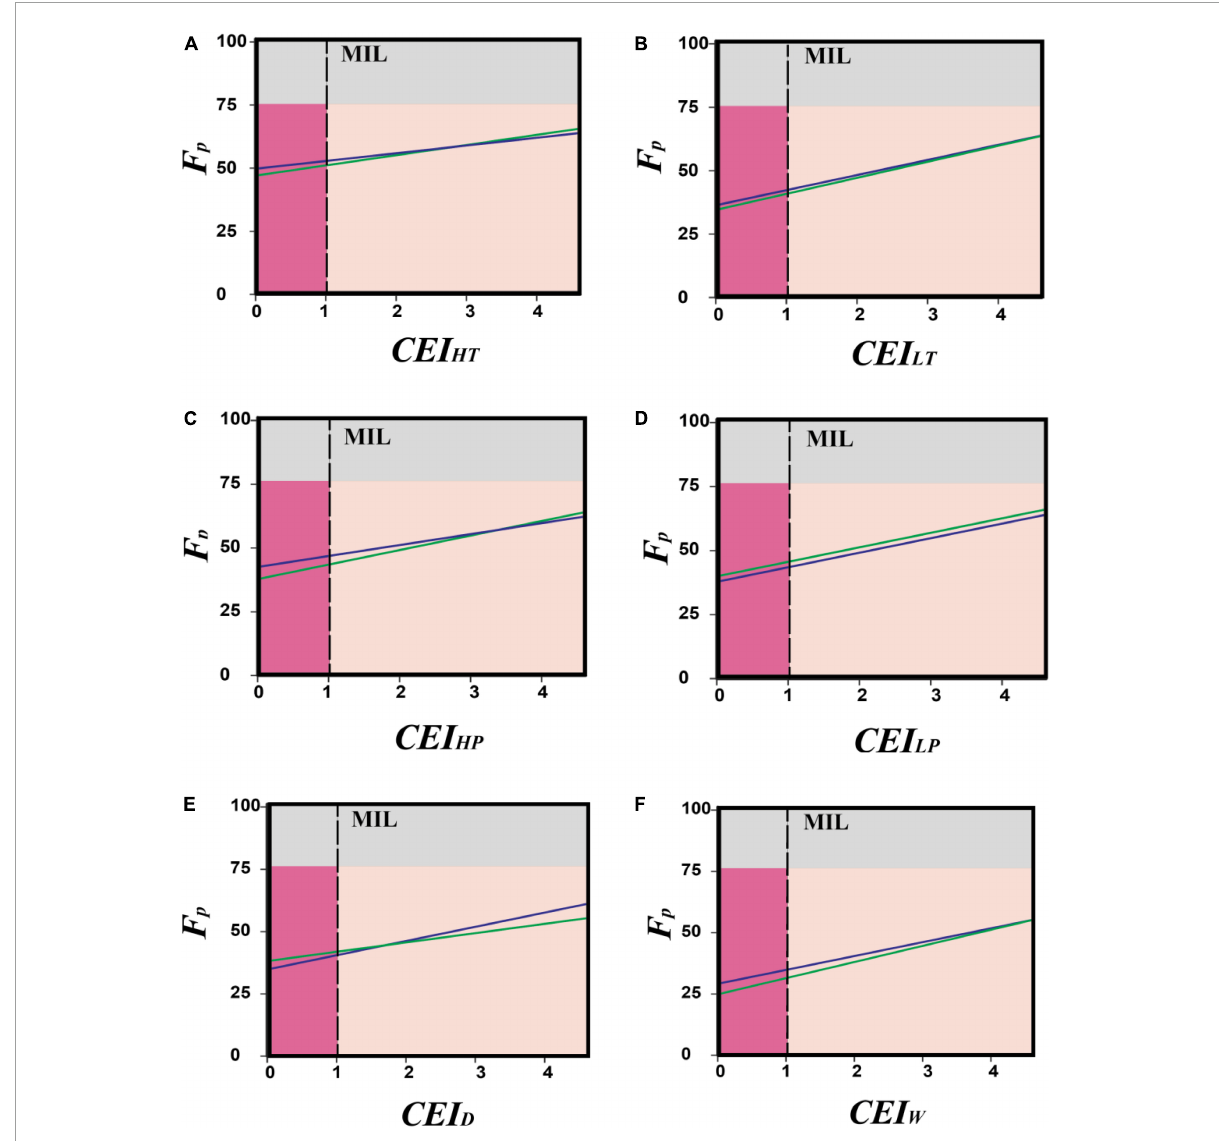
FIGURE3 A phenology forcing comparison between the observed data and the serial increment data of six extreme environmental categories, i.e., high temperature (A) , low temperature (B) , high precipitation (C) , low precipitation (D) , drought (E) , and wind speed (F) . climate extreme index values have been plotted on the x -axis, and the phenology forcing index value has been mentioned on the y -axis. Minimum impact limit